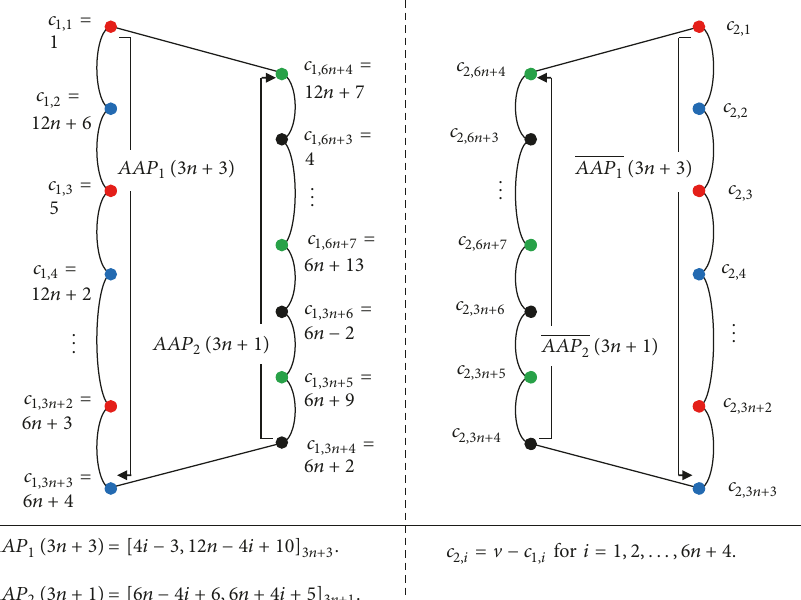
Figure 1: The construction of 𝐶 1 and 𝐶 2 in 2𝐾 V . 𝑛 is a positive odd